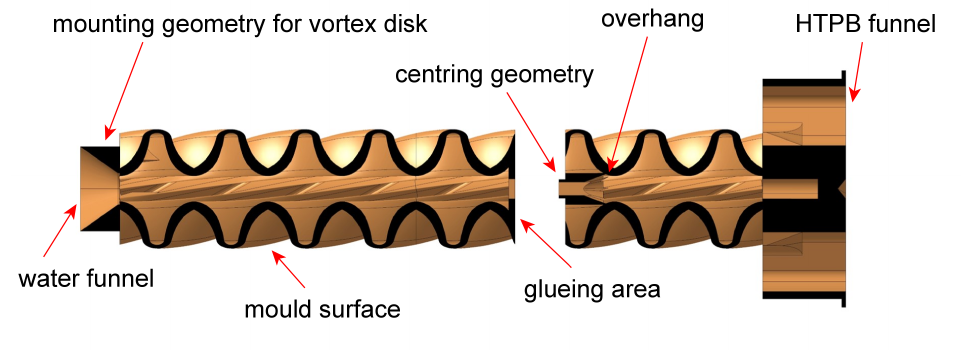
Figure 3. Sectional view of the two mold parts and gluing area.